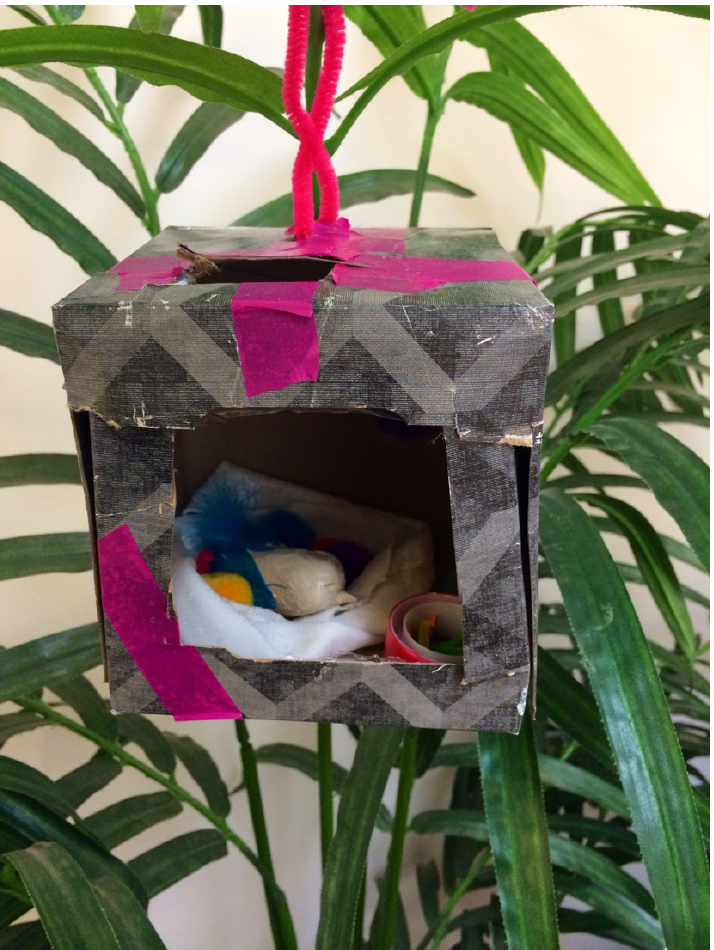
Figure 2Figure 2. A bird with no name . . . hanging in the therapy room. Mixed media (tissue box, clay, feathers, fabric, tape, paper cut, buttons,